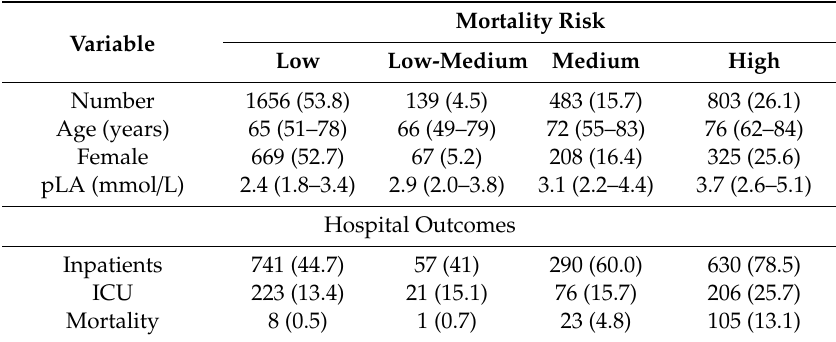
Table 4. Characteristics of study subjects by risk groups based on the